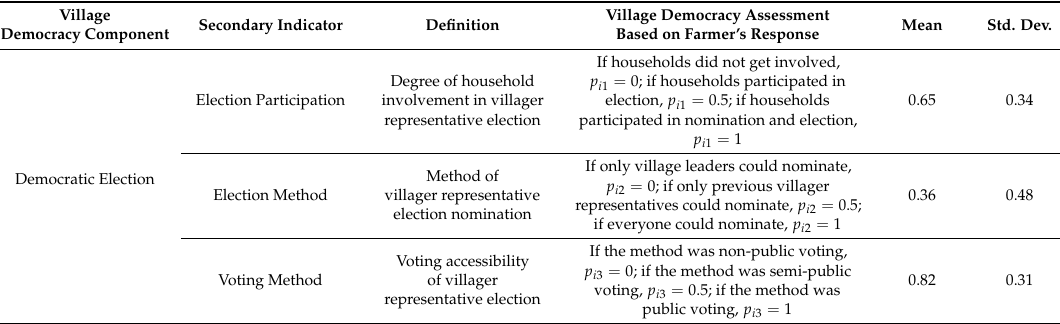
Table A2. Operationalization of variables in the measurement of village democracy and its descriptive